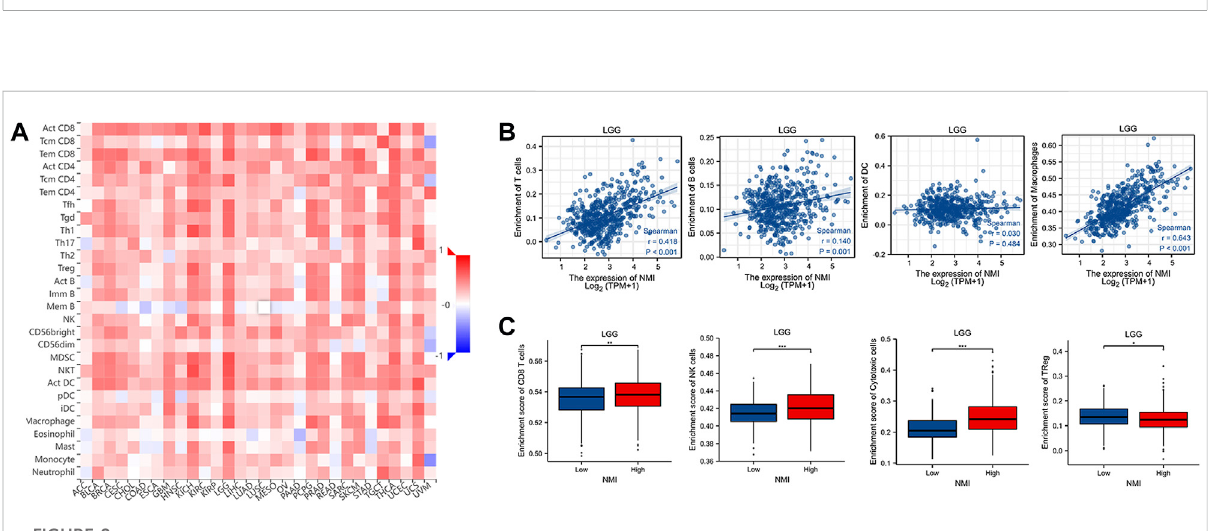
(Figure 7B), age > 40 years (HR = 3.52, p < 0.001) (Figure 7C), WHO grade = G2 (HR = 2.36, p = 0.021) (Figure 7D), laterality = left (HR = 3.89, p < 0.001)